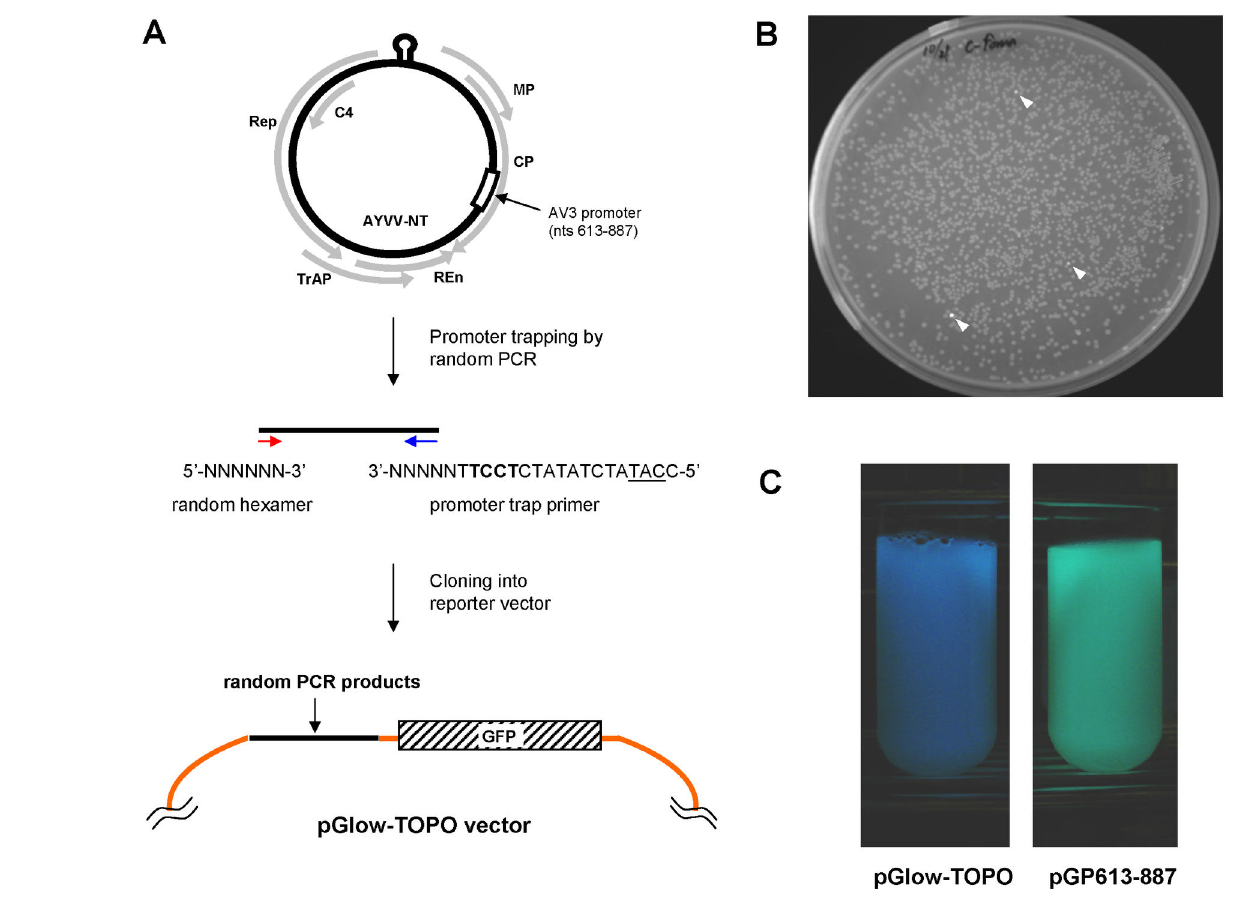
Figure 1. Identification of promoter activities in E. coli . (A) A schematic representation of the genomic map of AYVV-NT and the strategy used to randomly amplify fragments of AYVV-NT genome. The positions and directions of the known ORFs are indicated by the grey arrows. Random PCR products were cloned into the promoter trapping vector, pGlow-TOPO ® to identify the fragments with potential prokaryotic promoter activities in E. coli . The position of AV3 promoter is indicated by open box. (B) Examination of colonies with a handheld UV illuminator at 365 nm. The fluorescent colonies are indicated by the white arrowheads. (C) One selected colony (as indicated) was grown in the LB medium and examined under UV